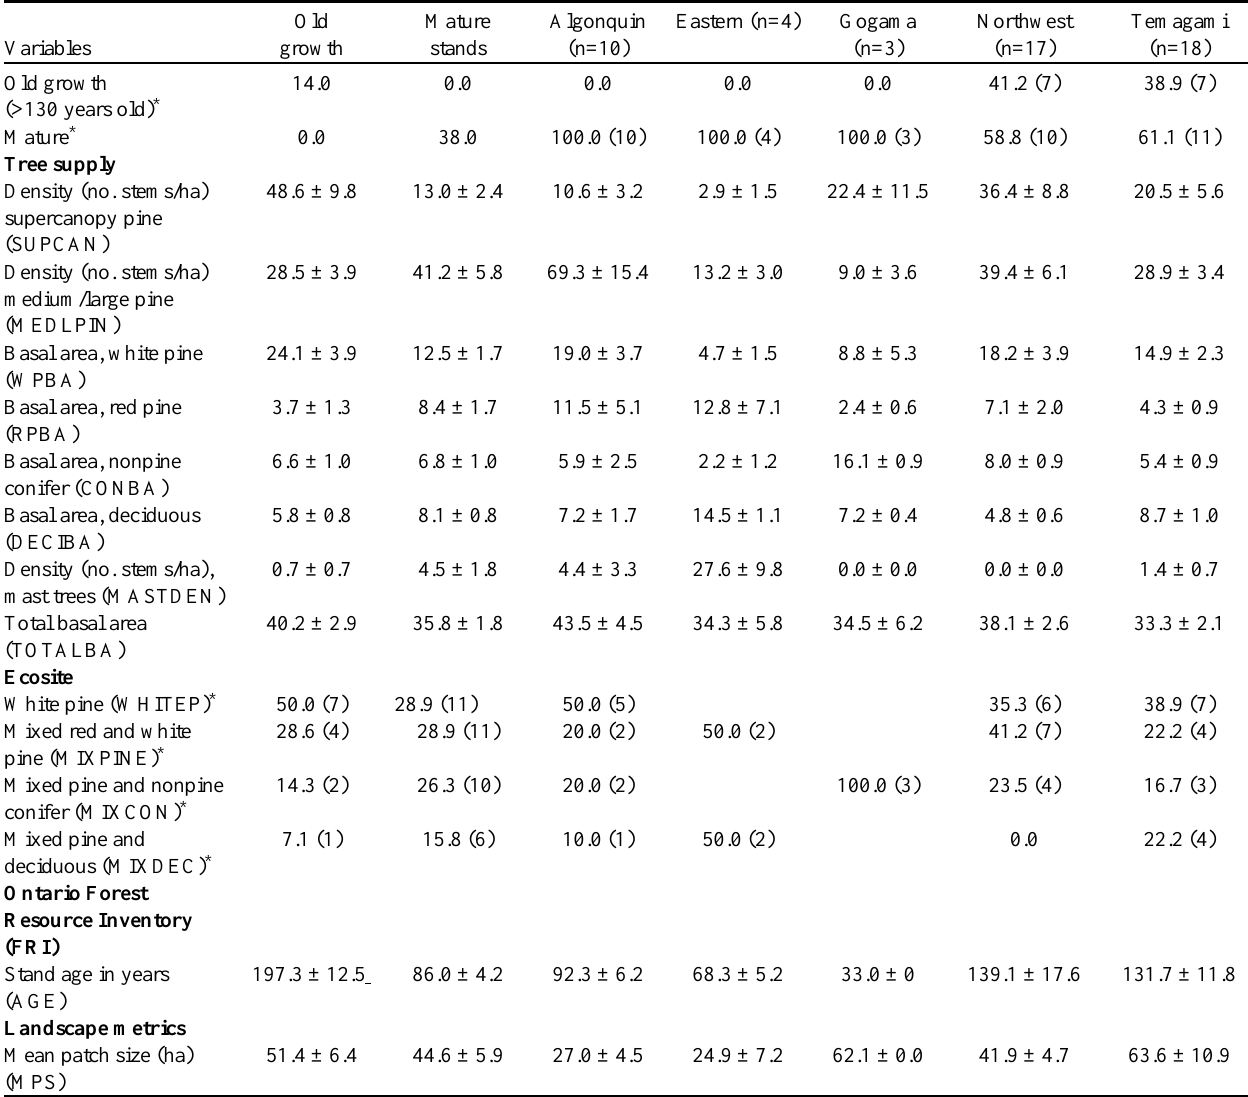
Table 1 . Vegetation features for all pine forests sampled in five regions of Ontario, Canada. Numbers show mean ± SE, categorical variables (denoted by *, numbers show % of stands, with n in